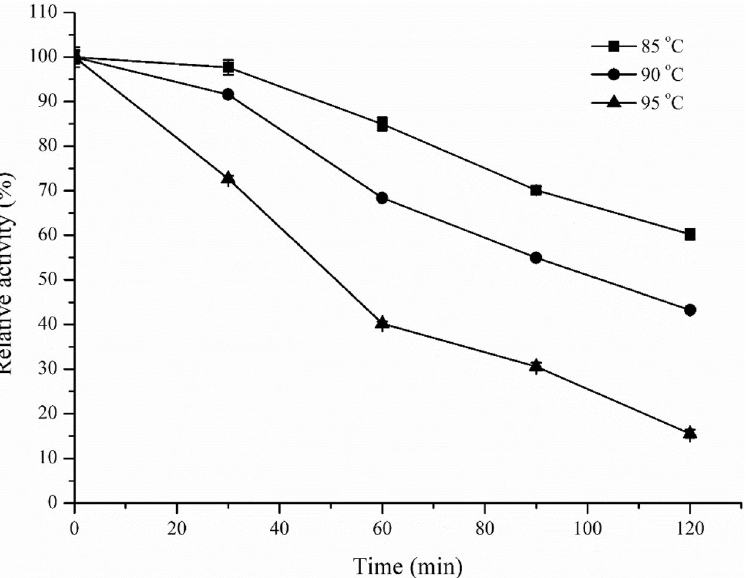
Figure 3. Thermostability of Fe-AAdh catalyzing ac-CoA to ac-ald. After the enzyme was incubated for different times in the absence of substrates, the residual aldehyde dehydrogenase activities were determined by using the standard method. The initial activity was defined as 100%.